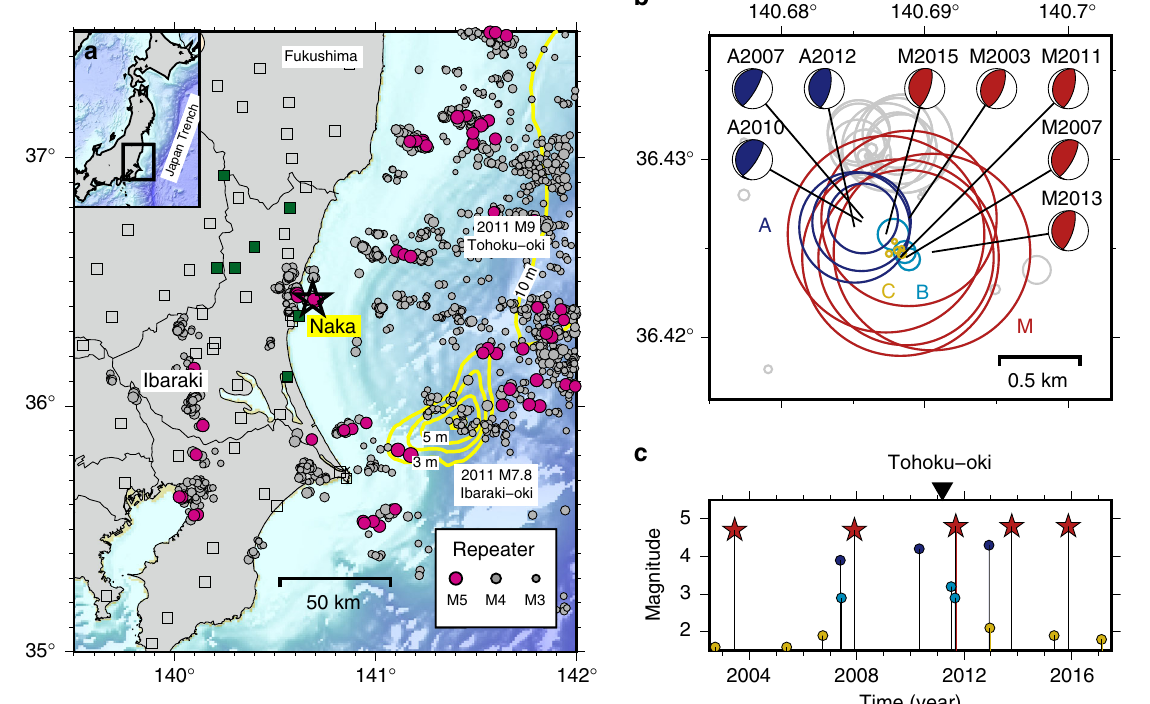
Fig. 1 Seismicity of the Naka region, Japan. a Map showing the epicentres of the repeating earthquakes 26 , with magenta and grey circles indicating M > 4.5 and smaller events, respectively. The yellow lines show the coseismic slip of the Tohoku-Oki earthquake 28 and the Ibaraki-Oki earthquake 29 . The green and open squares show the seismic stations used for seismogram comparison and relocation analysis, respectively. b Distributions of the Naka earthquakes. The centre and size of each circle represent the centroid location and expected source size, respectively. The red, blue, cyan, and yellow circles indicate groups M, A, B, and C, respectively. c Magnitude – time diagram of the grouped events. The triangle indicates the Tohoku-Oki